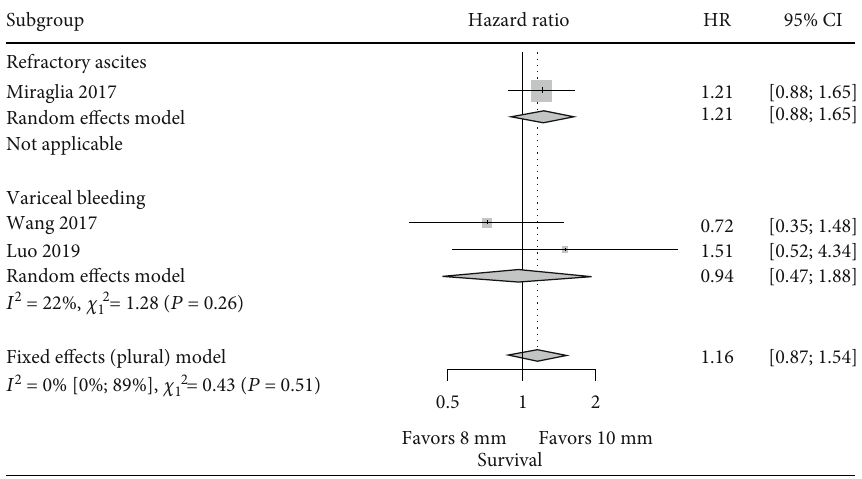
Figure 7: Subgroup meta-analysis of HR of survival in variceal bleeding and refractory ascites